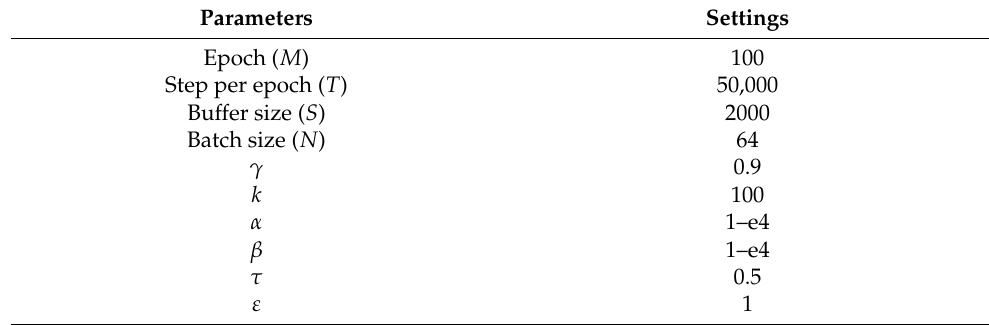
Table 3. Parameters of A2C